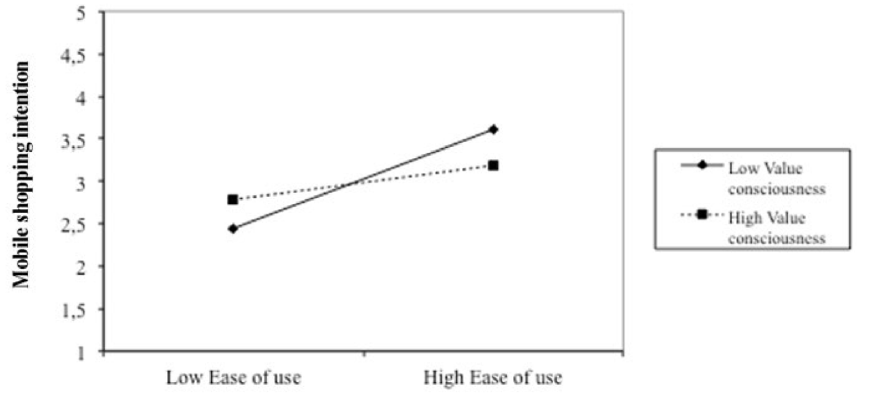
Figure 5. Relationship